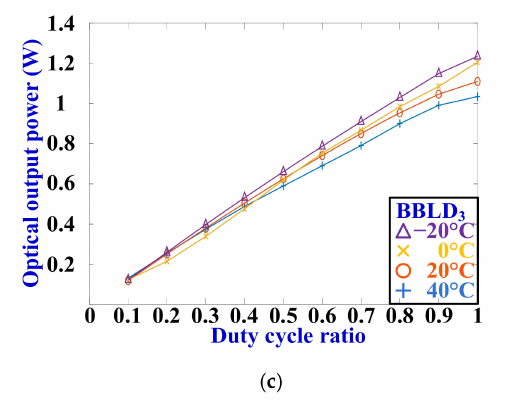
Figure 16. OOP ( P oop ( pdcm ) ) variations of PDCM in frequency of 250 Hz. ( a ) BBLD 1 . ( b ) BBLD 2 . ( c ) BBLD 3 .